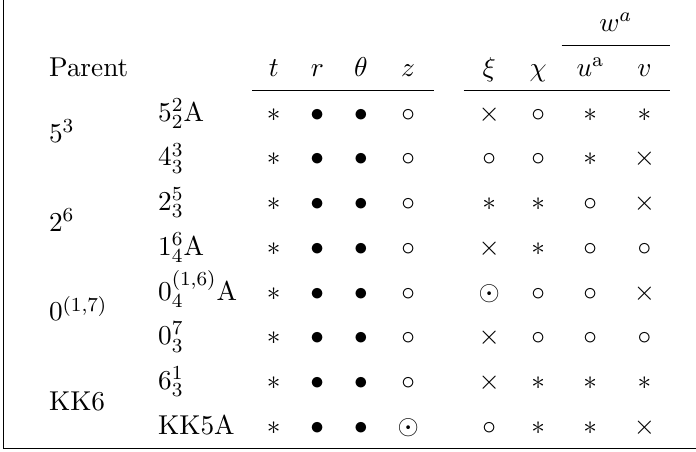
Table 2 . The con(cid:12)guration of the Type IIA branes that we consider. Note that the coordinates heading the columns are those of the M-theory section. A cross (cid:2) denotes the direction that is being reduced